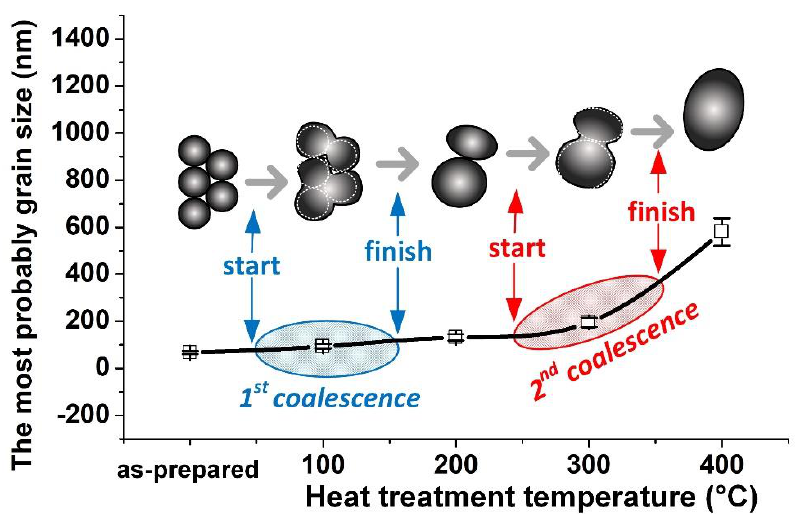
Figure 2. An increase in the most probable grain size upon heat treatment during two stages of coalescence. The most probable grain size was defined as the maximum of the function describing the grain size distribution in accordance with the Gauss law.